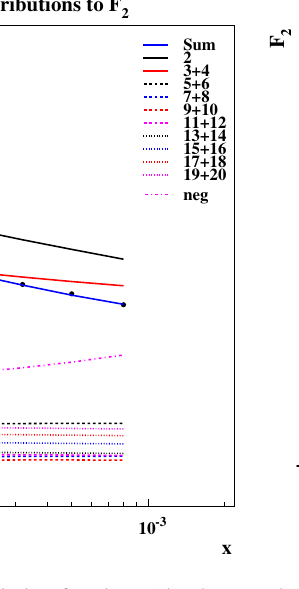
the second eigenfunction and the continuous negative ω contributions, the contributions of the eigenfunctions are displayed as a sum of two eigenfunctions, ( 3 + 4 ),( 5 + 6 ),...( 19 + 20 )